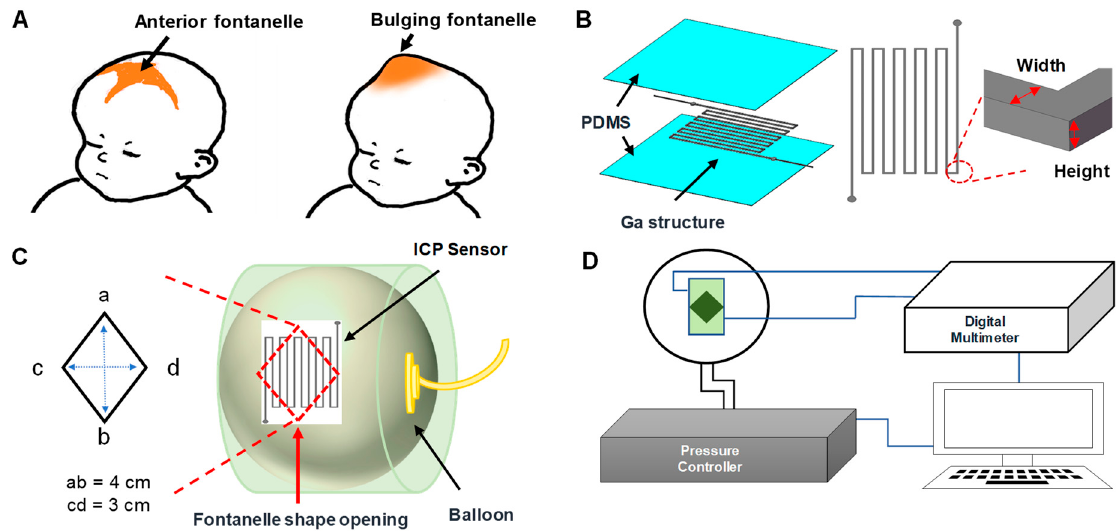
Figure 1. ( A ) An infant with a normal fontanelle (left) and a bulging fontanelle (right). ( B ) An illustration showing the design of the ICP sensor. ( C ) An image of the developed balloon-in-box fontanelle model (inset: opening area of the fontanelle model). ( D ) A schematic illustration of the overall experimental setup.